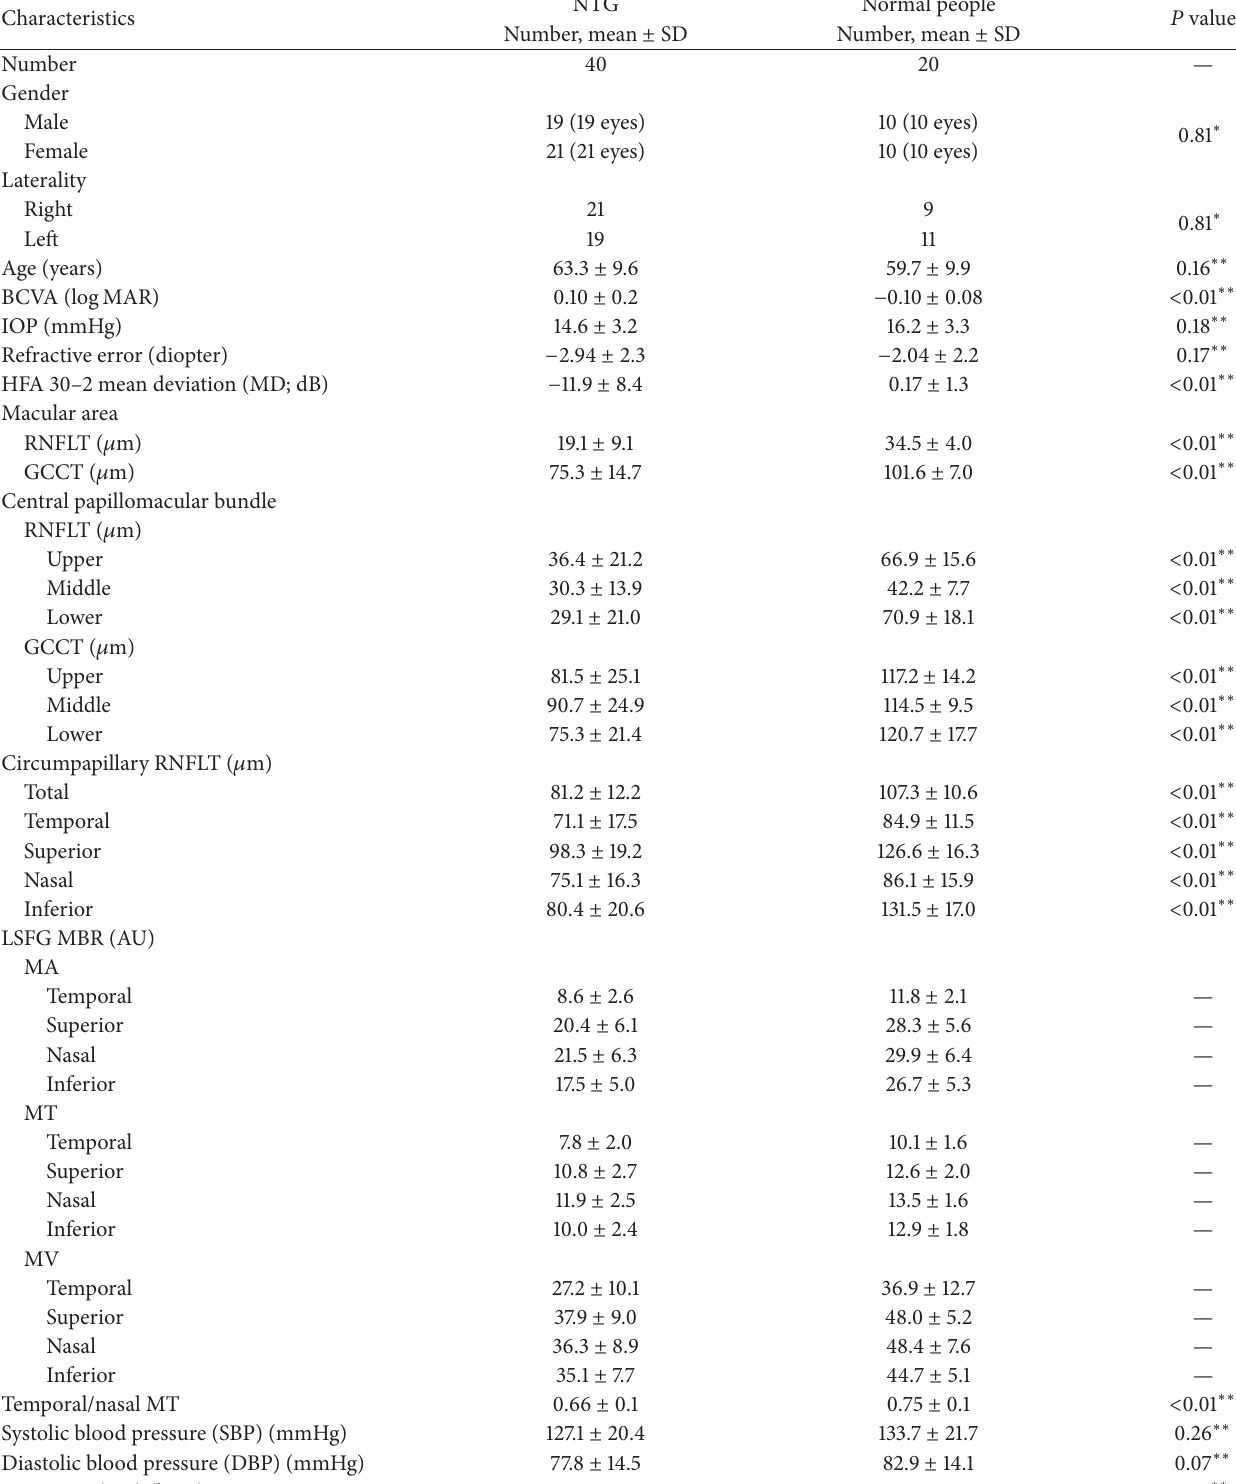
Table 1: Characteristics of